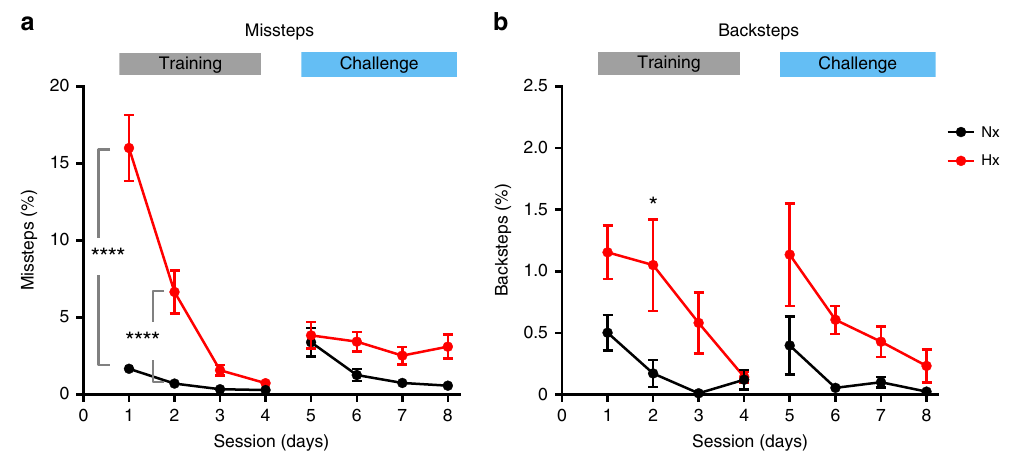
Fig. 2 Locomotor performance measured using the Erasmus Ladder is altered in Hx mice. a Misstep percentage recorded by the Erasmus Ladder for Nx (black, n = 8), and Hx mice (red, n = 11). Training sessions (day 1 through day 4) are highlighted by overhanging grey bar ( “ training ” ). Challenge sessions (day 5 through day 8) are highlighted by overhanging blue bar ( “ challenge ” ). Statistics: two-way ANOVA, treatment effect F (1,136) = 63.08, P < 0.0001,